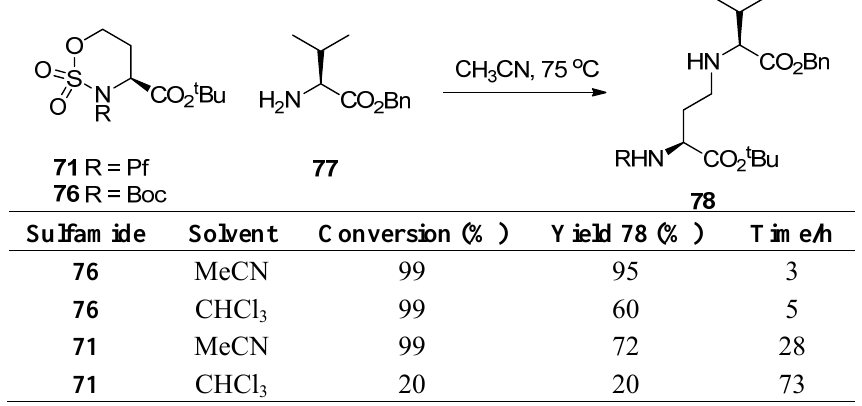
Table 12. Differences in reactivities of N -Pf and N -Boc-sulfamidates in nucleophilic addition